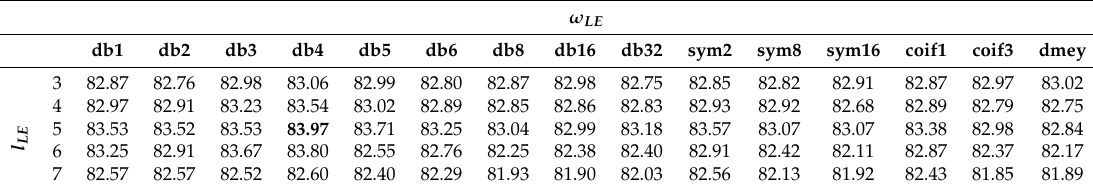
Table 17. The accuracy (%) of four class sleep stage classification with different ω LE and l LE under R&K standard.